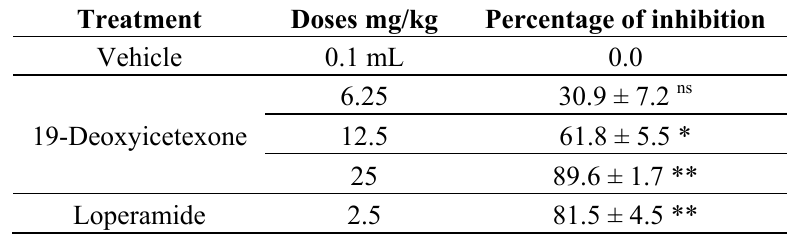
Table 2. The antidiarrheal effects of 19-deoxyicetexone on mice induced castor oil-induced